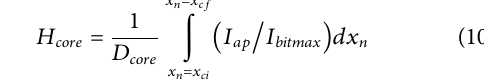
Frontiers in Physiology |